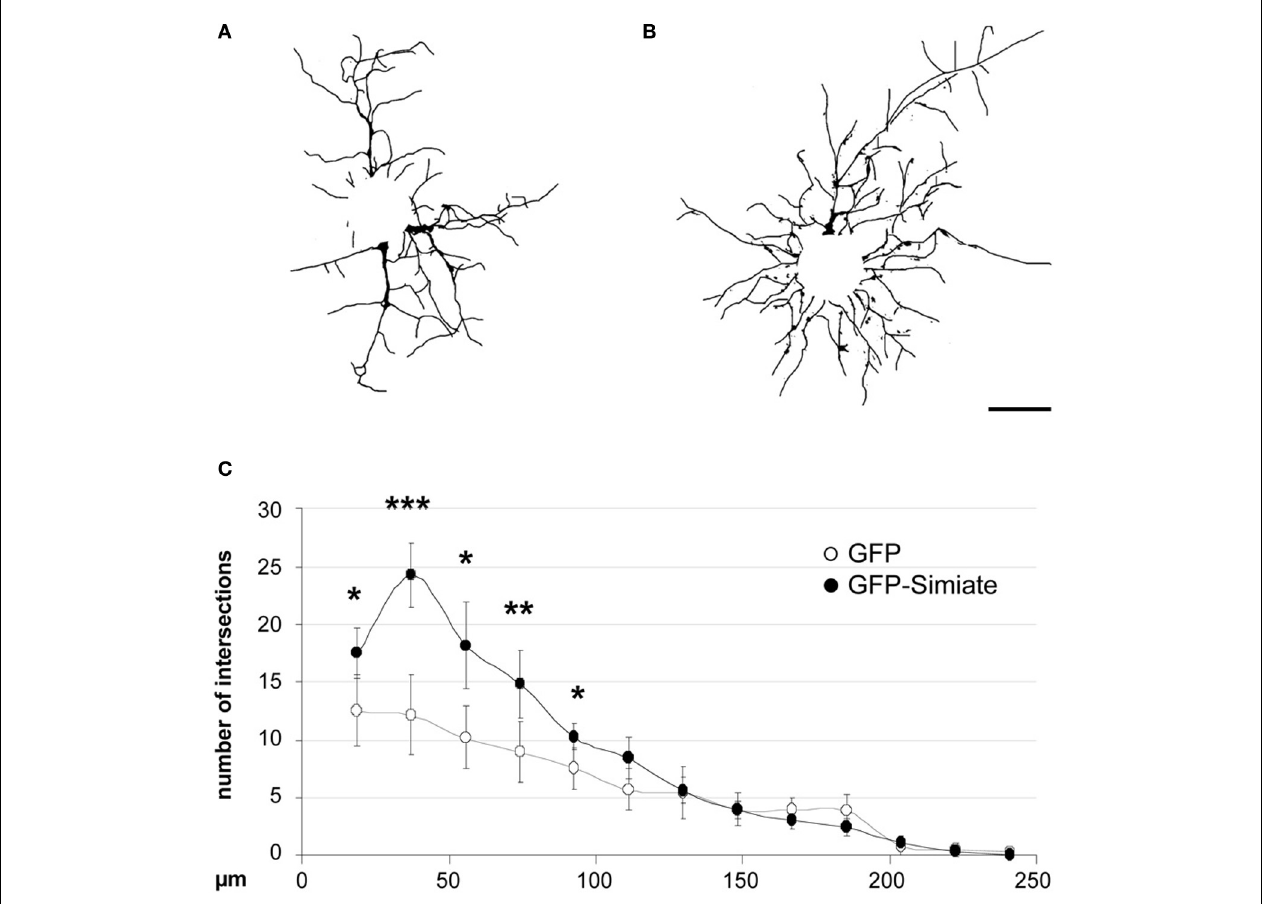
FIGURE 7 | Simiate is involved in the arborization of neurons. (A,B) Reconstructed dendritic arborizations of representative pyramidal neurons expressing GFP (A) or GFP-Simiate (B) ,